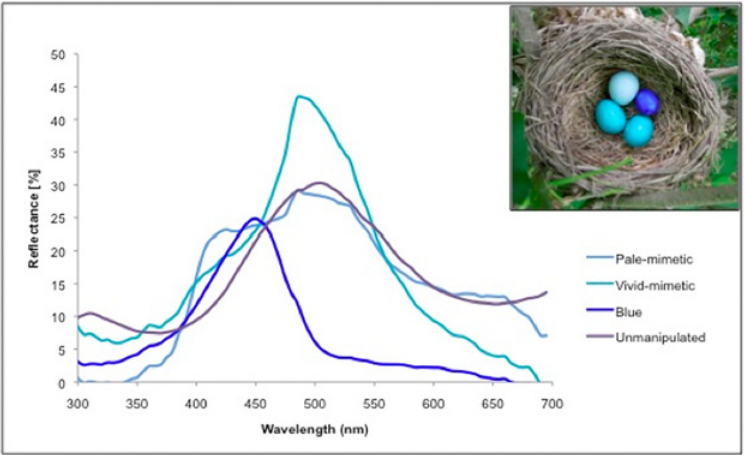
Fig 1. Representative egg color spectra, with experimentally manipulated nest (inset). Representative spectra showing each of the three colors used in the egg rejection experiment, in addition to natural American robin egg spectrum. Pale-mimetic and vivid-mimetic paints were used to manipulate the color of real robin eggs. Blue paint was used to color plaster-of-Paris model parasitic eggs. The unmanipulated spectrum represents the average spectrum of real robin eggs. Inset shows a representative nest with experimentally increased variation in egg color, showing two natural robin eggs painted with vivid-mimetic paint, one painted with pale-mimetic paint, and one blue model egg.